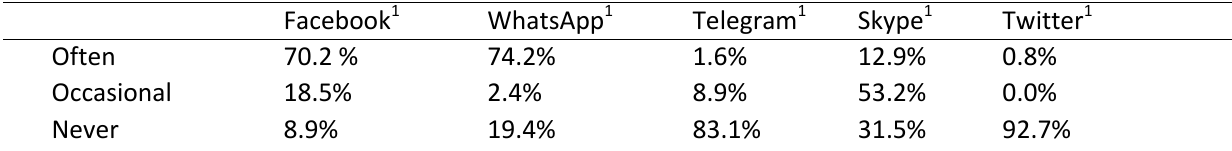
Table 2: Use of social media by third year veterinary students (n =